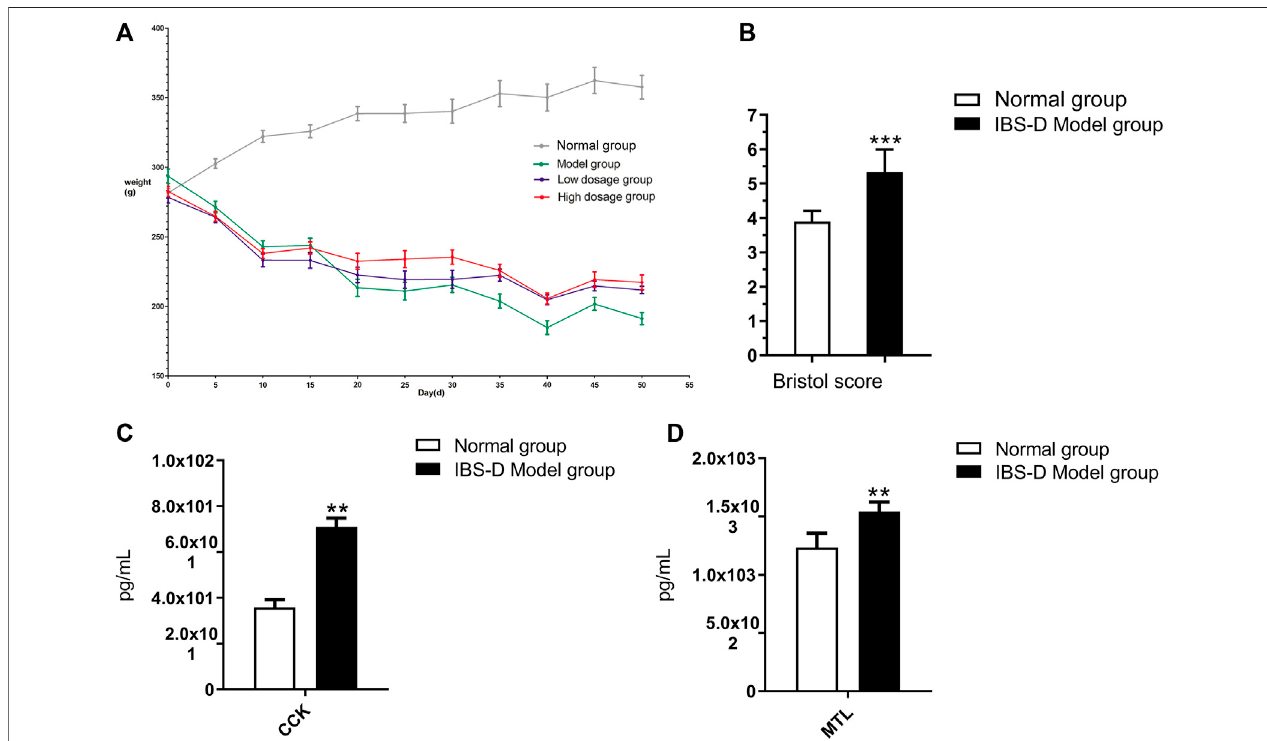
FIGURE 1 | Bodyweight changes (A) , the Bristol fecal character score (B) , the level changes of CCK (C) , and MTL (D) . * p < 0.05 and ** p < 0.01 vs. normal group. ▲ p < 0.05 and ▲▲ p < 0.01 vs. model group.